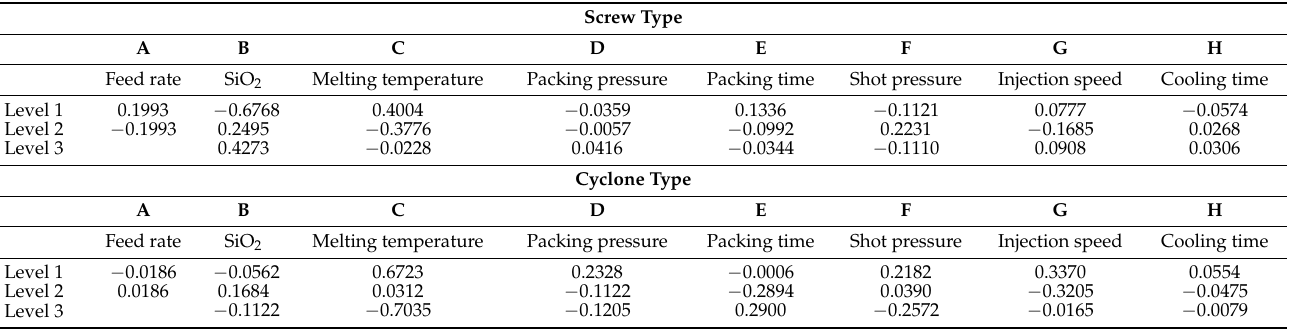
Table 7. The total principal component score.